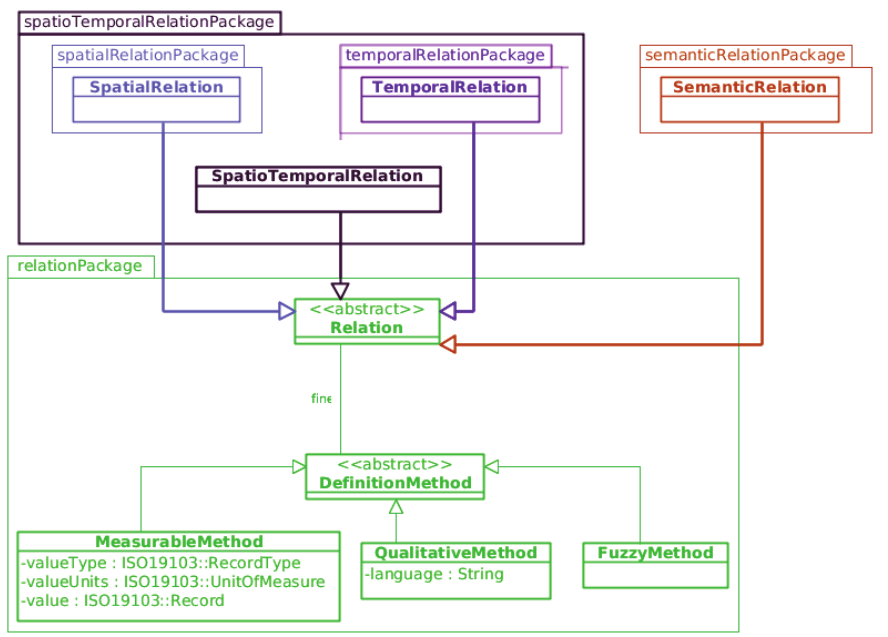
Figure 6: Relation